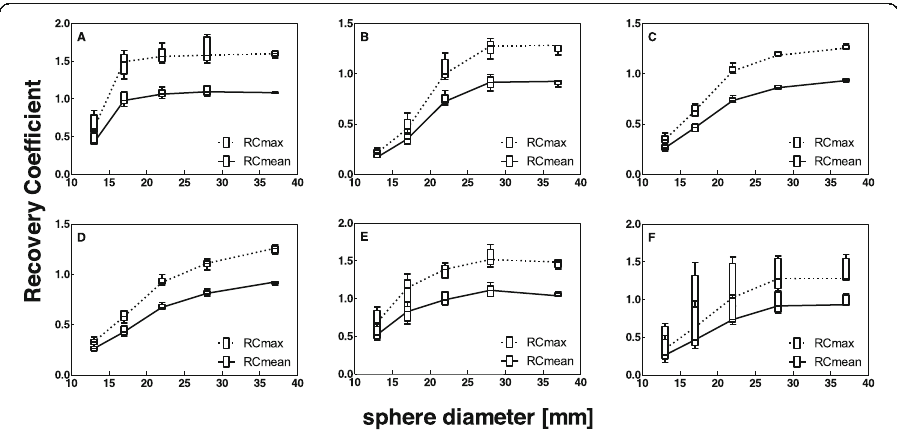
Fig. 3 Recovery coefficient as a function of sphere diameter for all systems separately ( a – e ) and for all systems combined ( f ), for data reconstructed with a vendor-specific algorithm. Median and box plot for five repetitive measurements per system. ( a ) GE Discovery NM/CT 670 Pro, ( b ) Philips Precedence 6, ( c ) Siemens Symbia Intevo 6, ( d ) Siemens Symbia T16 system 1, ( e ) Siemens Symbia T16 system 2, ( f ) Median RC values for all systems